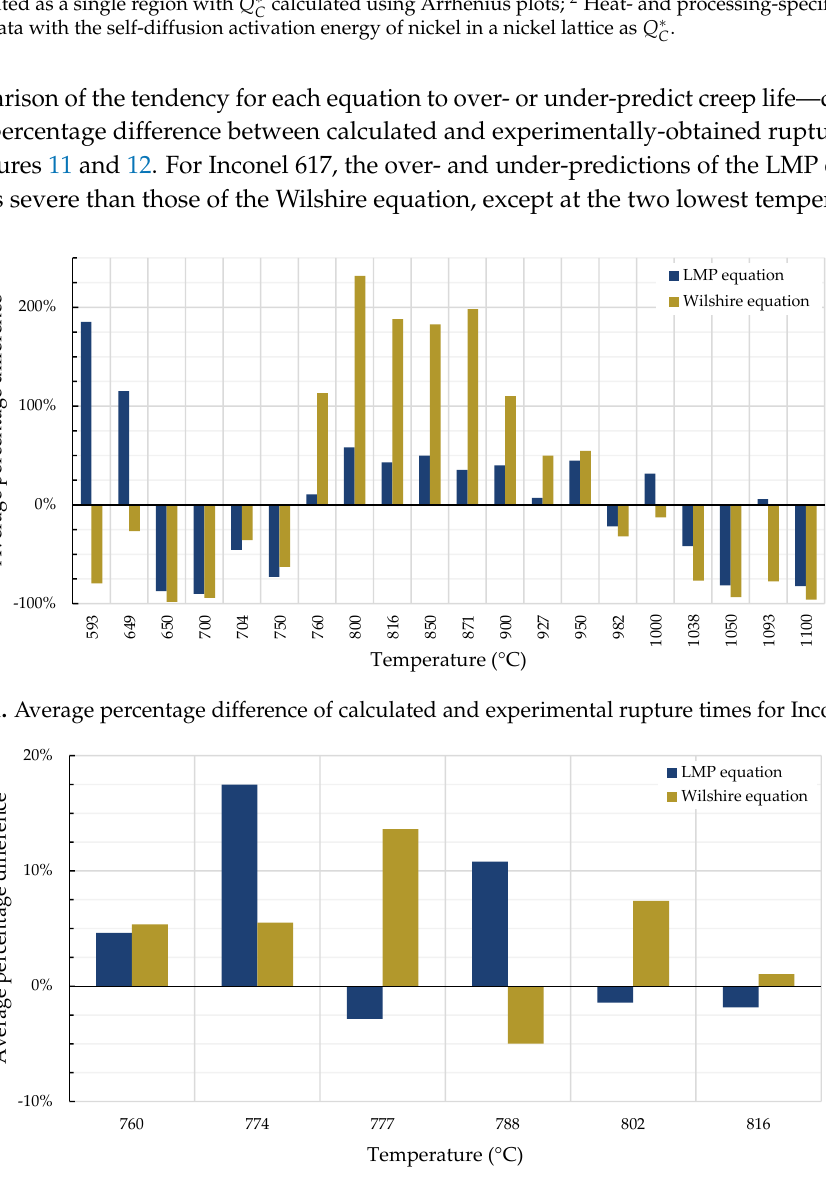
Table 11. Percentage differences of the calculated rupture times for the longest test durations.